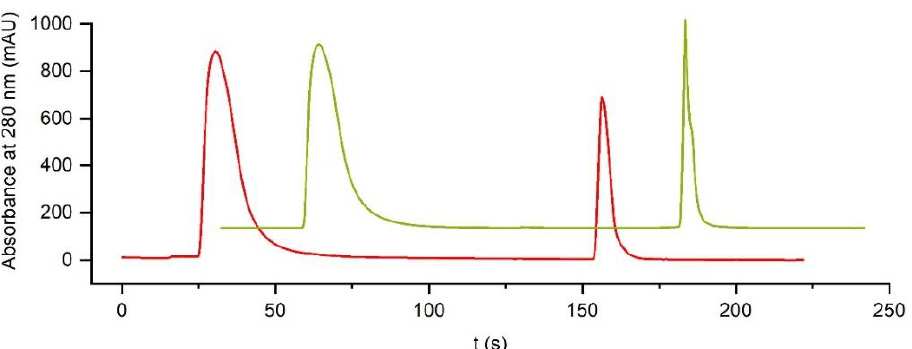
Figure 7 . Effect of a reversed elution on a VitraPOR 5 column. To optimize the peak shape of the eluted product, a reversed elution (green curve) was tested in comparison to the normal elution in the usual flow direction (red curve).